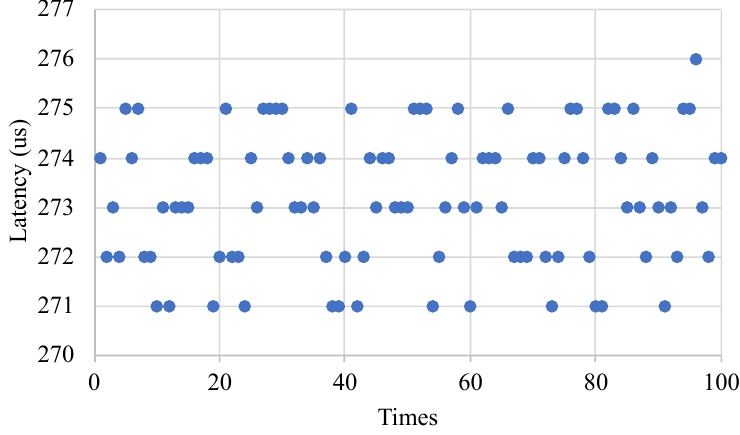
Figure 14. The round-trip communication latency between the control plane and the data plane.